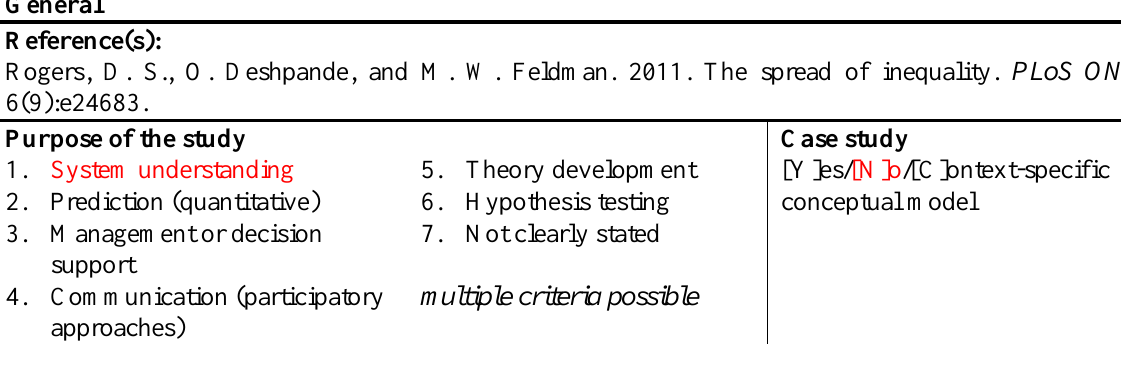
Table A1.10 Standardized protocol for the ABM described by Rogers et al.